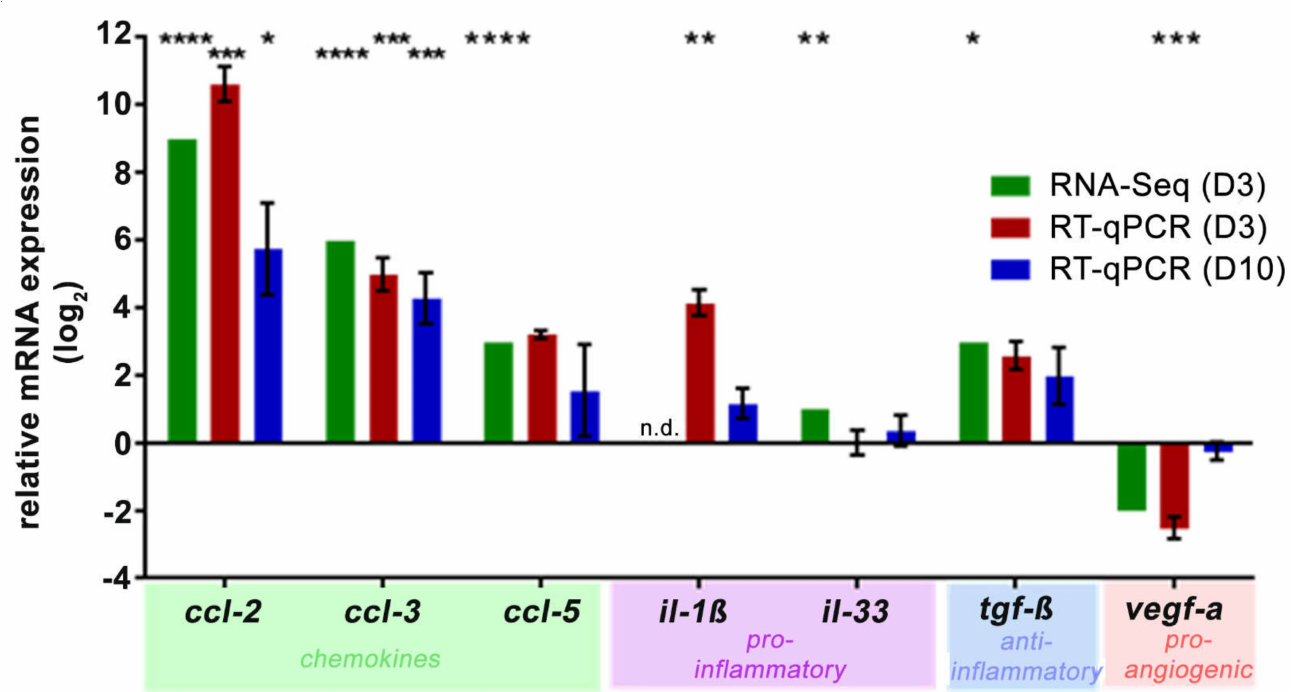
Figure 6. NaIO 3 increased the retinal transcription of the chemokines and cytokines. RNA-seq (day 3, green) and RT-qPCR analysis (day 3, red; day 10, blue) of the ccl-2, 3, 5, il-1 β and tgf- β expression showed a significant upregulation after the NaIO 3 treatment. Il-33 was not significantly upregulated, whereas vegf-a was decreased on the mRNA level at day 3 following the treatment. The expression was normalised to the overall gene set (RNA-seq) or idh3b reference mRNA (RT-qPCR), and the fold change in the expression (compared to the untreated control, line at y = 0) was calculated on the logarithm to base 2. * 0.01 < p < 0.05, ** 0.001 < p < 0.01, *** 0.0001 < p < 0.001 and **** p < 0.0001 (ordinary one-way ANOVA and Tukey’s multiple comparisons